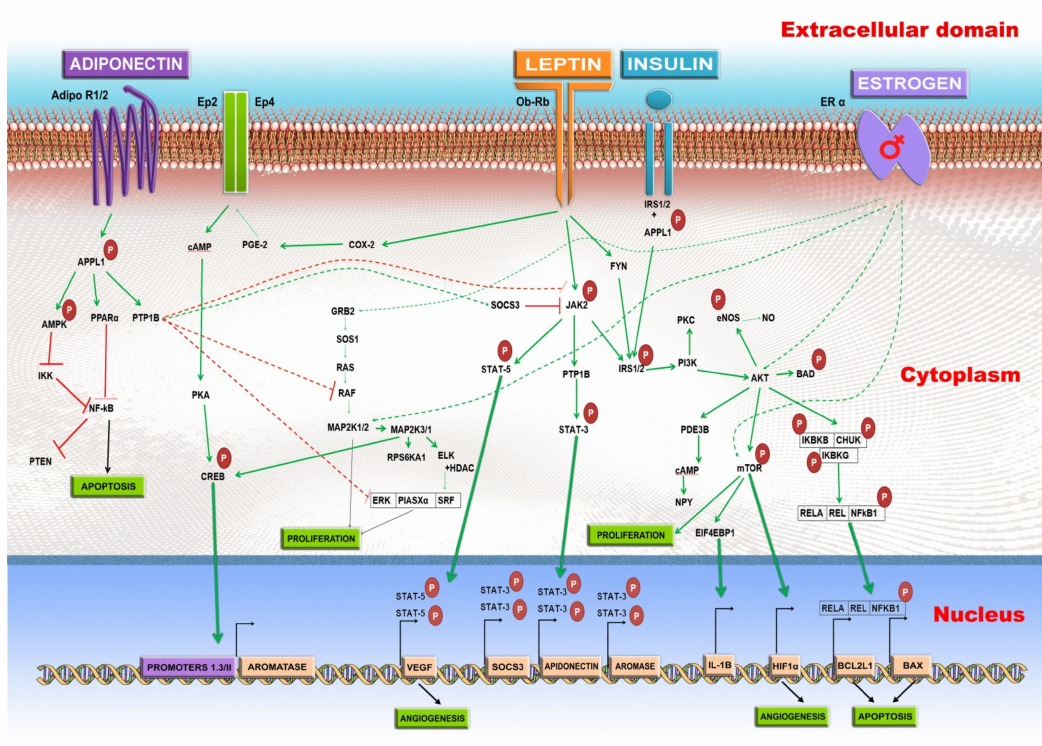
Figure 1. The pathways activated by several dysregulated hormones in central obesity. The green arrow stands for activation and the red line for repression. Leptin binds to the Ob-Rb receptor, and activates several signaling pathways. The JAK2-STAT3 pathway is activated; which will result in the stimulated transcription of the SOCS3 , and ultimately AROMASE (CYP19A) genes. The JAK-STAT5 pathway results in the increased expression of vascular endothelial growth factor (VEGF), which leads to angiogenesis. The IRS1 / 2-PI3K-AKT is also stimulated by Ob-Rb receptor which increases the NO level, and activates BCL2 associated agonist of cell death - BAD . The IRS1 / 2-PI3K-AKT stimulation also leads to the activation of mTOR which increases the proliferation, and stimulates the expression of HIF-1 α , respectively, it initiates the angiogenesis process. The AKT interaction with the IKBKB / CHUK / IKBKG complex is followed by the activation of RELA / REL / NF κ B1 which will lead to the increased expression of BCL2 Like 1- BCL2L1 , and BCL2-associated X, apoptosis regulator- BAX, two genes which form a complex involved in apoptosis. The AKT activation phosphorylates the mTOR pathway, leading to the stimulated transcription of HIF1 α , IL-1 β , and increased proliferation. The leptin – Ob-Rb interaction causes the activation of COX-2 – PGE-2, and the prostaglandin and in EP2 / 4 receptor. This is followed by the cAMP-PKA-CREB activation. CREB will bind to the Promoter 1.3 / II of aromatase and it will stimulate the AROMASE (CYP19A) gene transcription. The adiponectin interaction with one of its two receptors, AdipoR1 or AdipoR2 leads to the adaptor protein, phosphotyrosine, interacting with PH domain and leucine zipper 1 APPL1 phosphorylation, which will activate protein tyrosine phosphatase non-receptor Type 1-PTP1B. The PTP1B represses Janus kinase-JAK by direct interaction or through the activation of suppressor of cytokine signaling 3 - SOCS3. The tyrosine-protein phosphatase non-receptor type 1, also known as protein-tyrosine phosphatase 1B ( PTP1B ), also leads to the repression of RAF, and the ERK / PIASX alpha / SRF complex, thus inhibiting proliferation. The APPL1-PPAR α or APPL1 / AMPK-IKK causes the NF κ B inhibition, leading to apoptosis. The overstimulation of the ER leads to the activation of GRB2, AKT, and